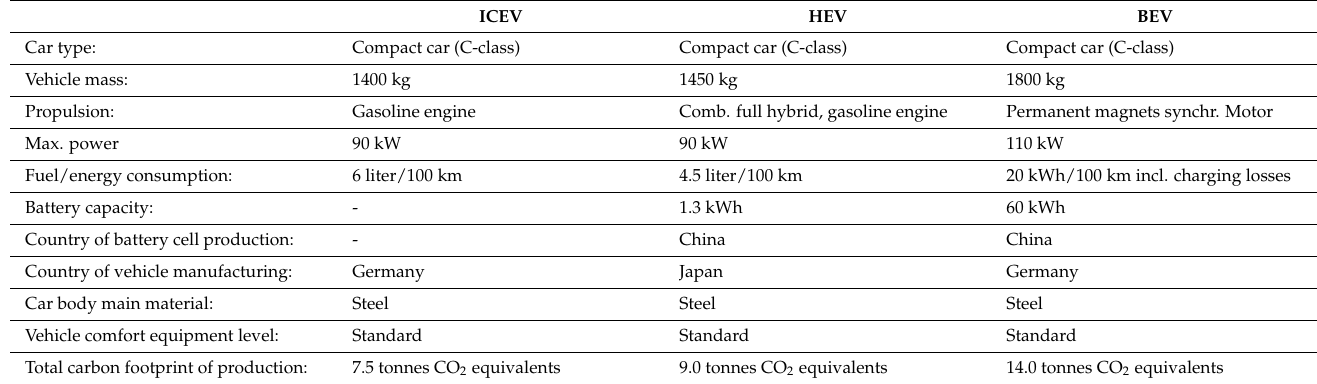
Table 1. Main characteristics of investigated cars with different propulsion technologies. ICEV